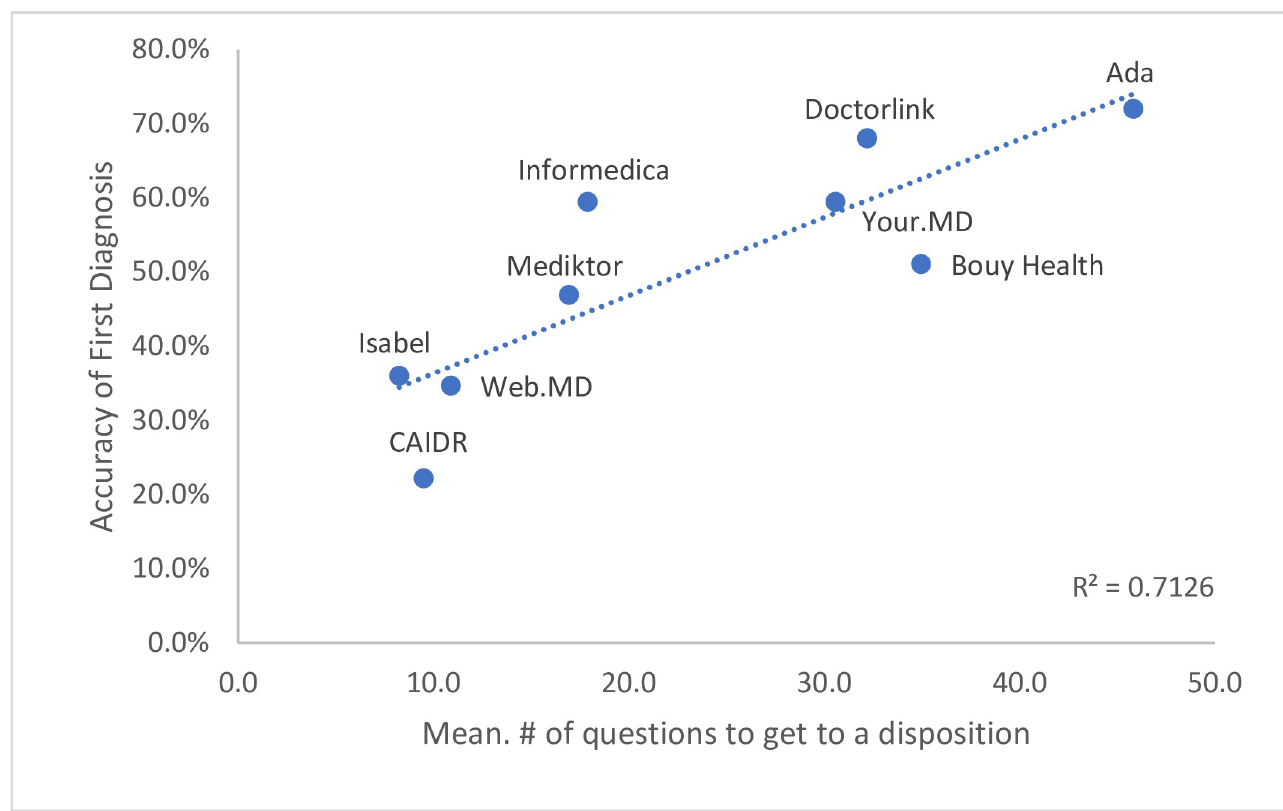
Fig 1. Correlation of mean number of questions to diagnostic accuracy listed